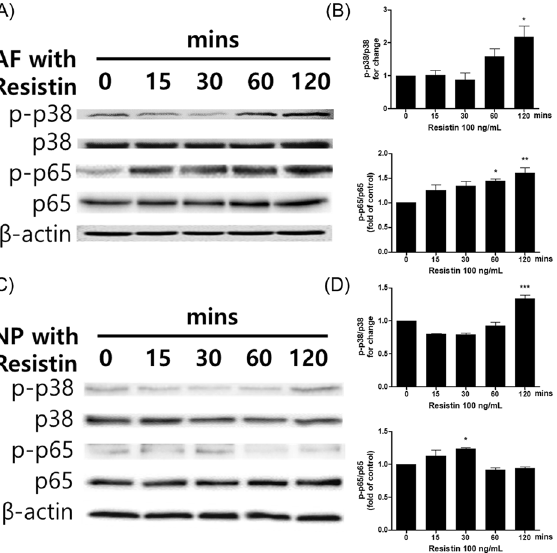
Figure 3. ( A,C ) The signaling pathway and ( B,D ) the densitometric quantification (*p < 0.05, **p < 0.01, and ***p < 0.001) of phosphorylated p38 MAPK and p65 NF-κB induced by 5 different durations of post-hResistin stimulation, compared to the unstimulated naïve control group (n = 5/group).